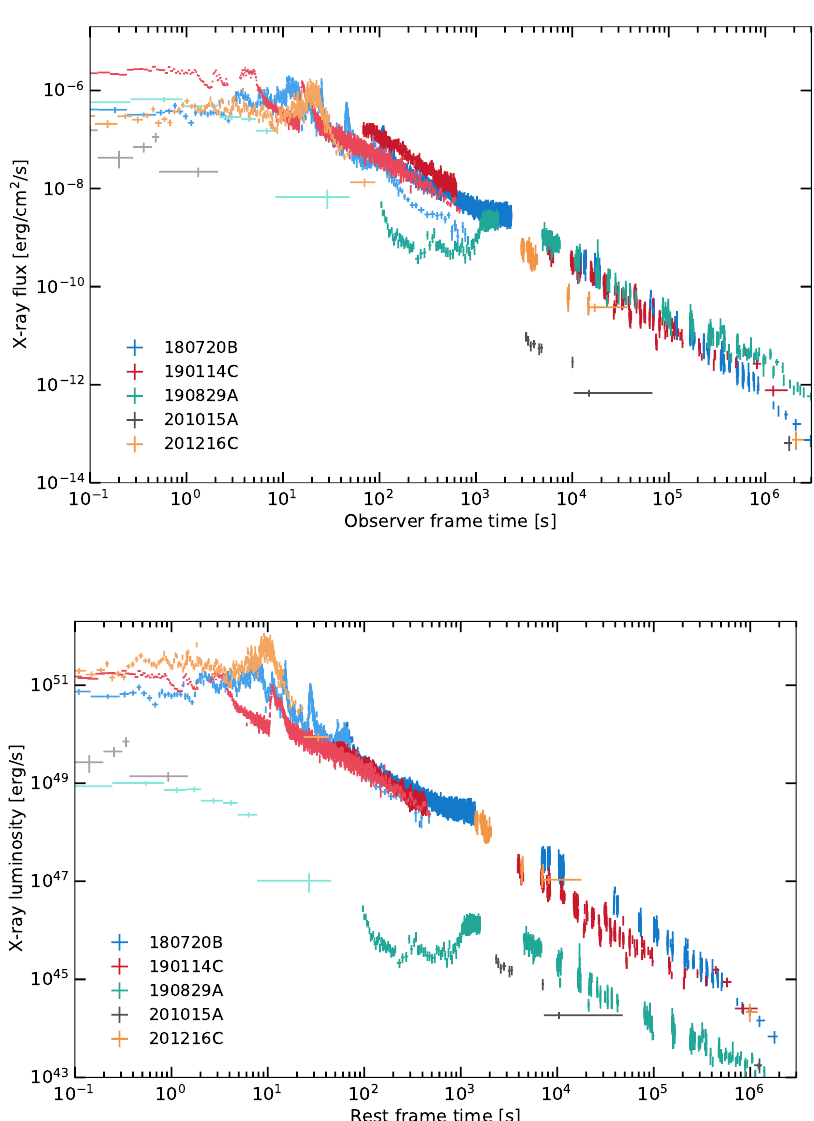
Figure 7. X-ray lightcurves of the long GRBs detected at VHE by MAGIC or H.E.S.S.. Different colours were used for different GRBs (see legend). For each GRB, the darker colour refers to the XRT, and the lighter colour was used for the BAT. Top : flux as a function of observer frame time since the trigger time (XRT: 0.3–10keV observer-frame, unabsorbed; BAT: 15–50keV). Bottom : luminosity as a function of the rest frame time (XRT: 2–10keV rest frame, unubsorbed; BAT: